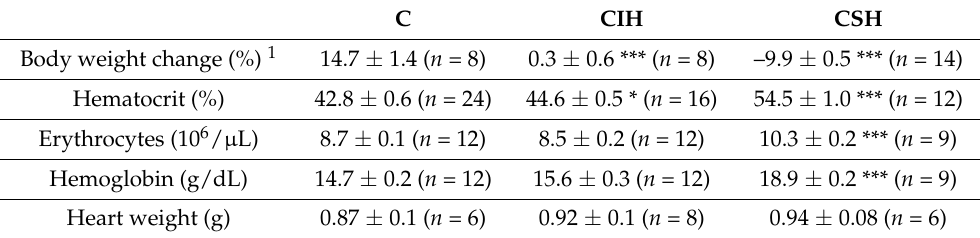
Table 1. Endpoint Physiological Variables. Weight changes and hematological parameters in rats exposed to normoxia (C), chronic intermittent hypoxia (CIH), and chronic sustained hypoxia (CSH). C